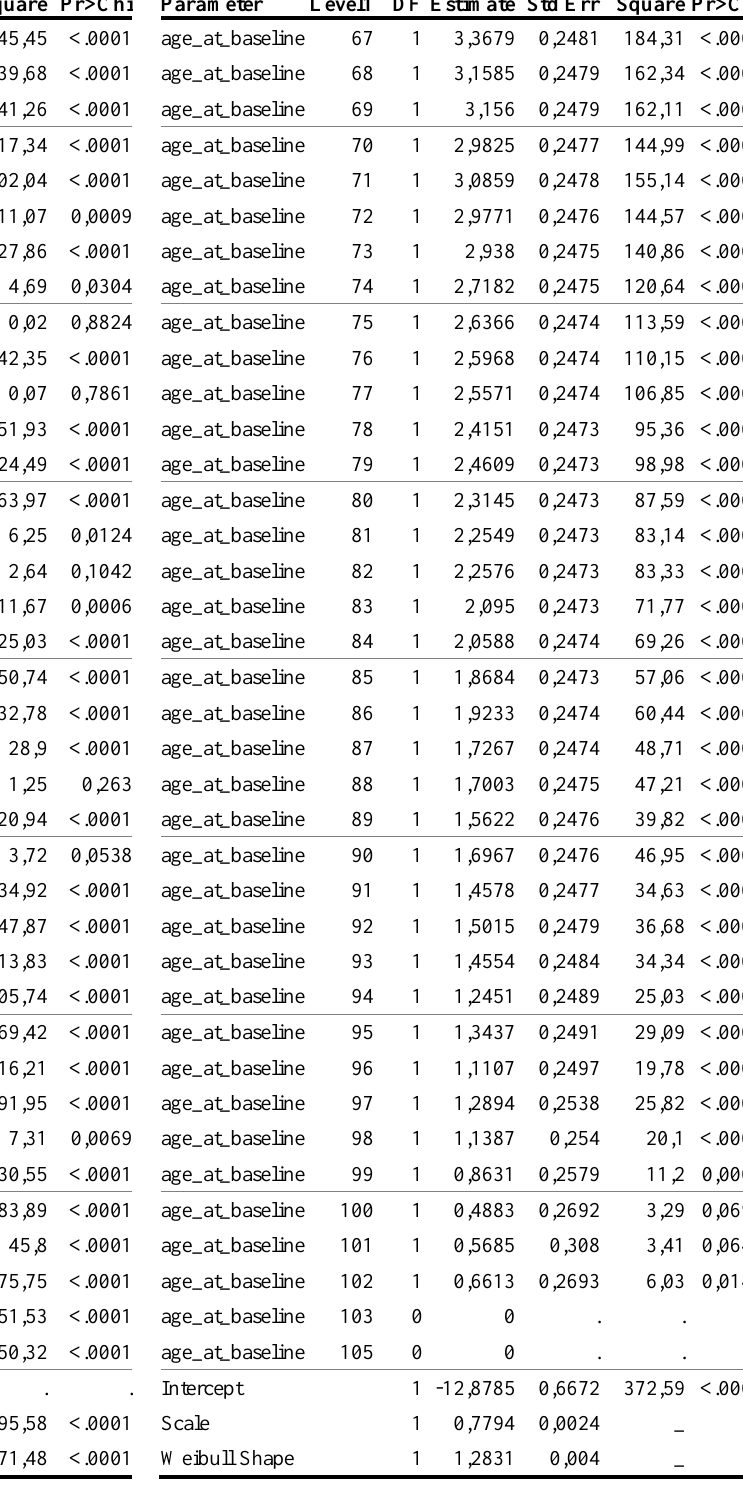
Table A1: Estimates of all parameters of model 4 in Table 9